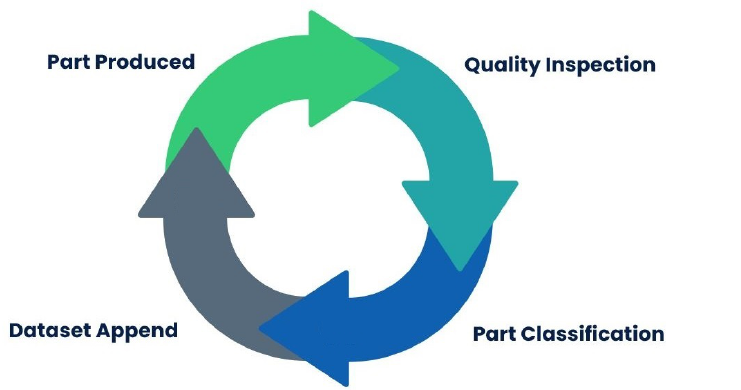
Figure 4. Human-in-the-Loop flow to create the training